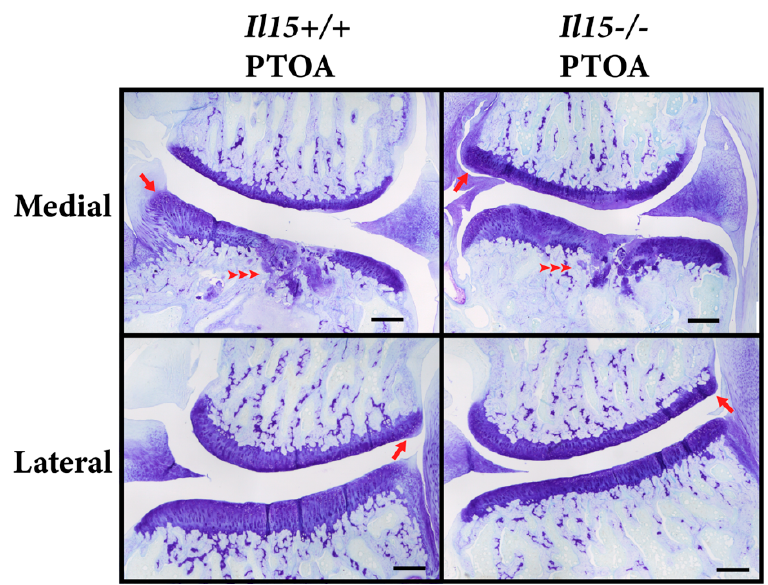
Figure 3. Representative histological images demonstrate greatest damage in the medial compart- ment of the PTOA group. Representative images of toluidine blue-stained paraffin sections of rat knees, demonstrating that the PTOA group had the greatest damage in the medial aspect as seen by osteophytes (red arrow), cartilage loss, and subchondral bone damage (red arrow heads). This damage was not significantly different between the Il15 +/+ PTOA and Il15 − / − PTOA rats. Images taken at 4 × magnification, scale bars represent 200 µ m (N = 15 rats/PTOA group).